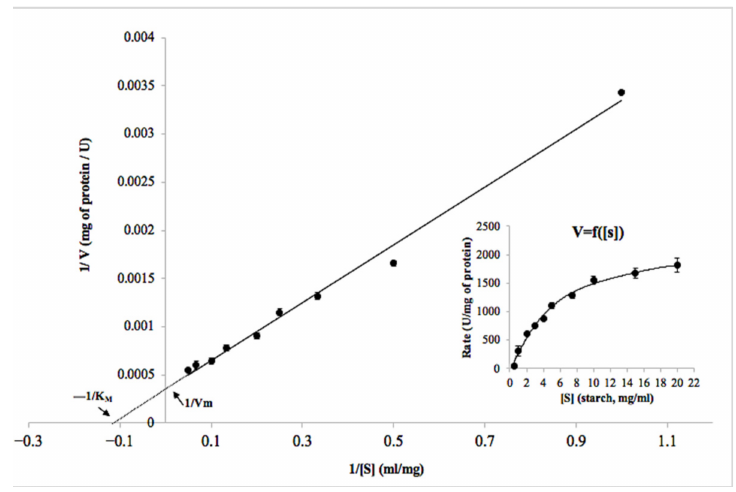
Figure 5. Lineweaver–Burk plot for the BCA α -amylase from blue crab viscera. Starch concentration varied in the range of 0–20 mg mL − 1 . K m and V max values were calculated from the plot. Inset shows the V = f ([S]) plot.